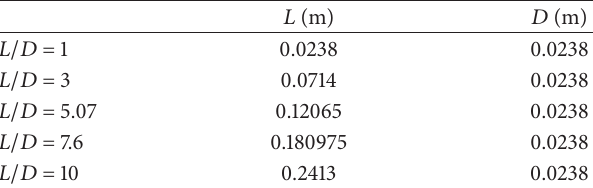
Table 2: 𝐿/𝐷 ratios of